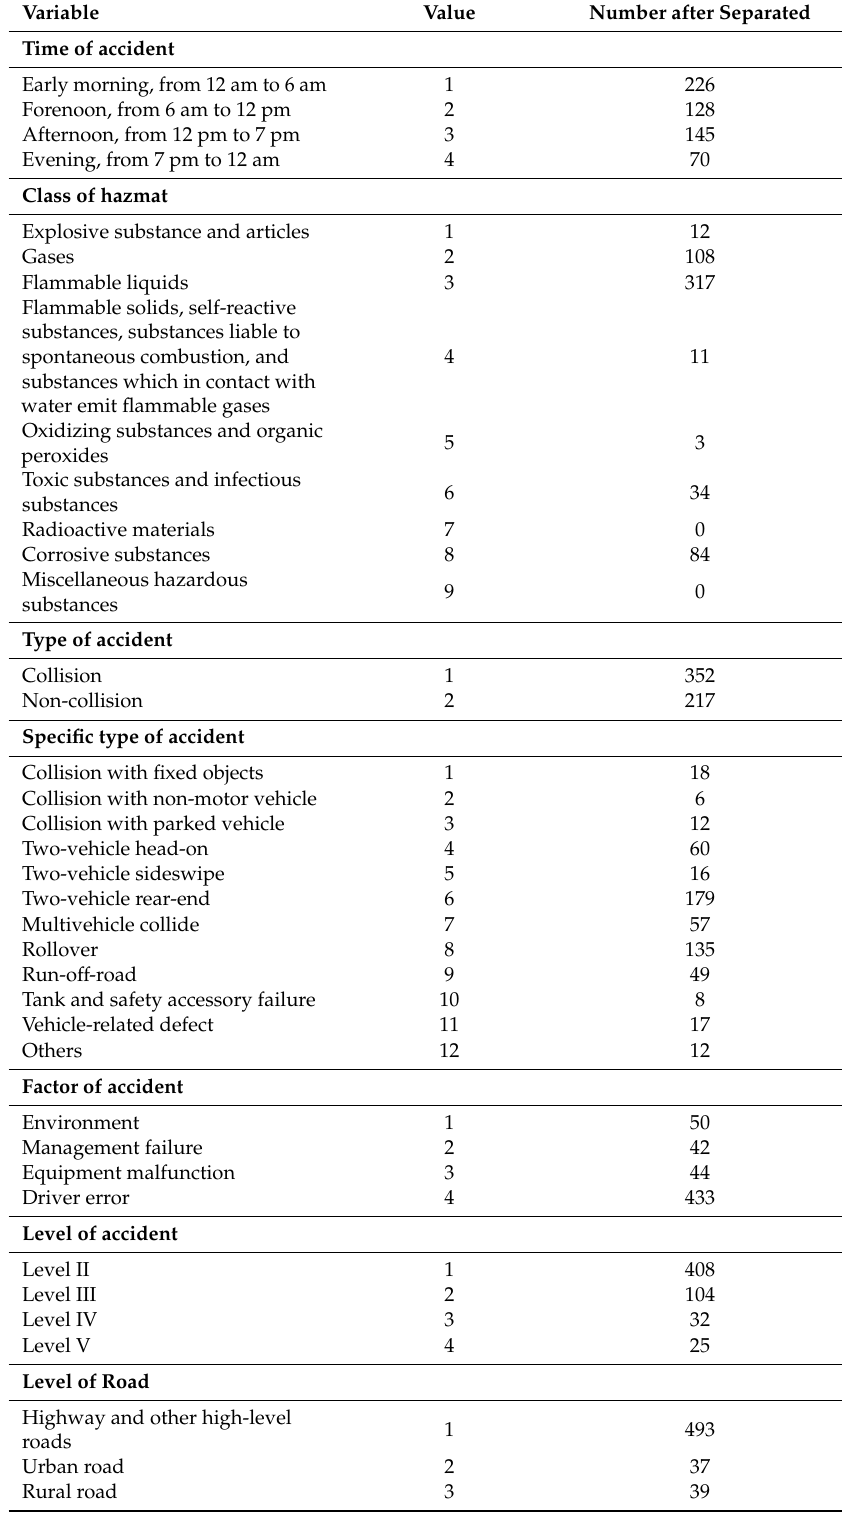
Table 2. The inputs of classification of independent variables for the decision